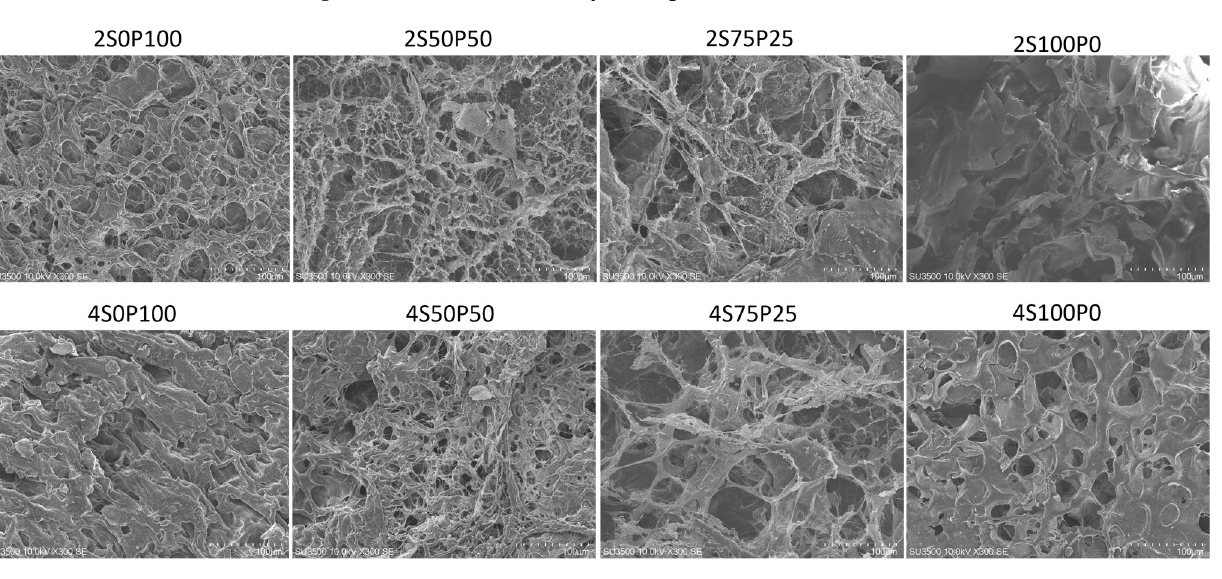
Figure 3. SEM images of the hydrogel surface at a concentration of 2% and 4% with various sericin and PVA ratio compositions.